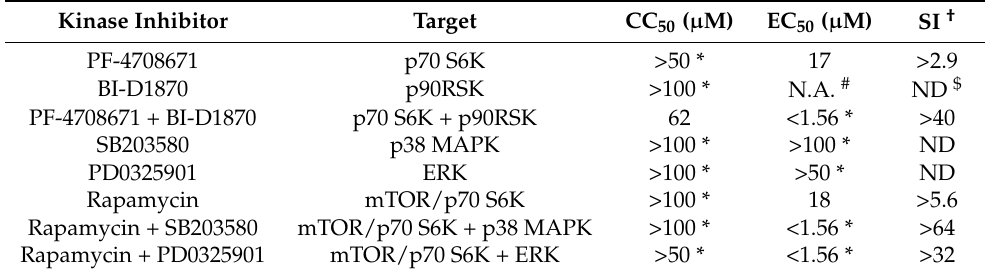
Table 1. Summary of kinase inhibitors used and their activities against Rift Valley fever virus (RVFV). Kinase